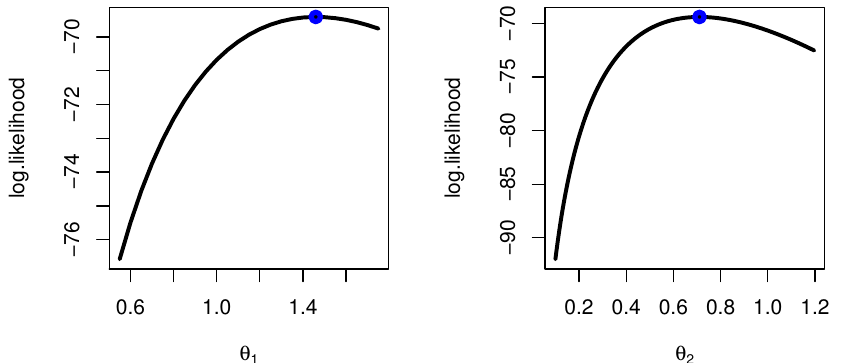
Figure 8. Profile likelihood for parameter estimation by SRS method for failure times of insulating fluid data.